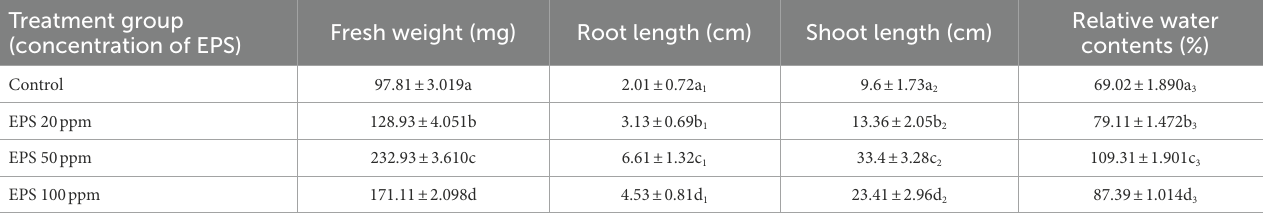
TABLE 6 Different physical parameters (fresh weight, root length, and shoot length) of GRH-treated and untreated drought-faced rice seedlings are represented here. Treatment group Fresh weight (concentration of EPS)